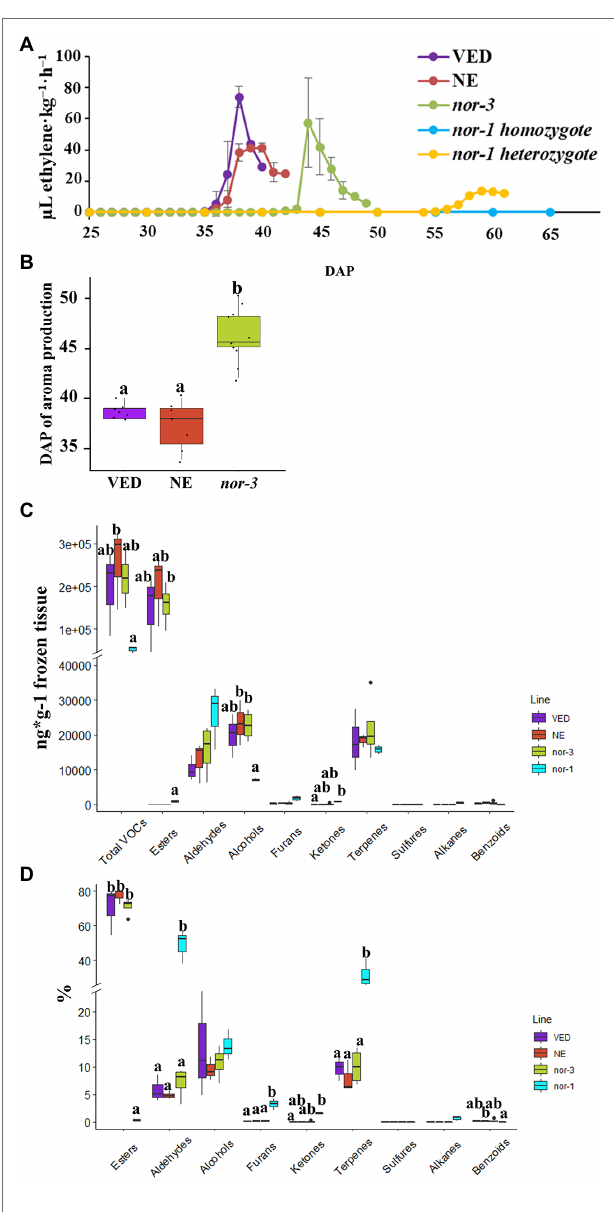
FIGURE 2 | Ethylene production and volatile profile in nor mutants. (A) Ethylene production in VED, NE (non-edited control), nor-3 , nor-1 homozygote , and nor-1 heterozygote according to days after pollination (DAP). Means are plotted ±SD ( n = 5) except nor-1 heterozygote ( n = 1). (B) Phenotypic comparison of aroma production in VED, NE, and nor-3 at harvest. Lower case letters indicate significant differences ( p < 0.05, n > 5). (C,D) Relative volatile content in VED, NE, nor-3 , and nor-1 at harvest by mass (C) and mass percentage (D) . Lower case letters indicate significant differences ( p < 0.05, n = 3); large size black dots represent